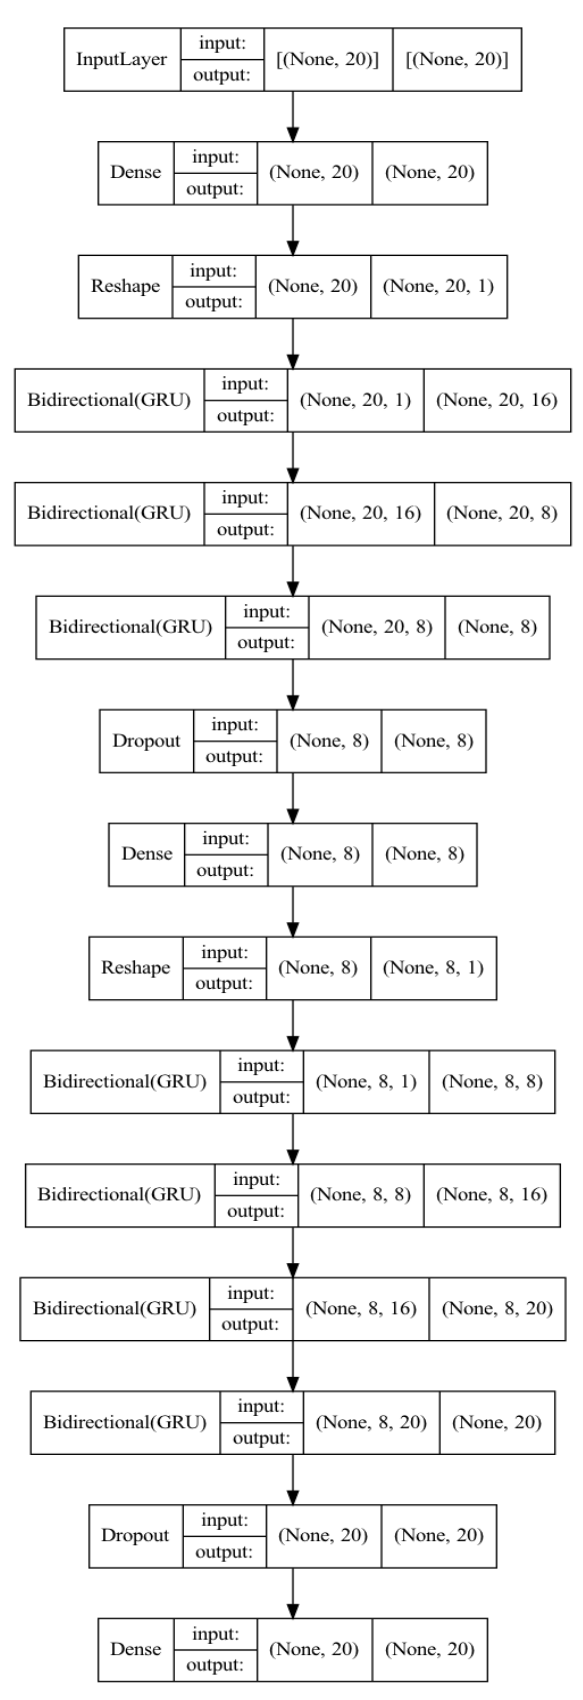
Figure 11. Autoencoder model of UNSW-NB15 and